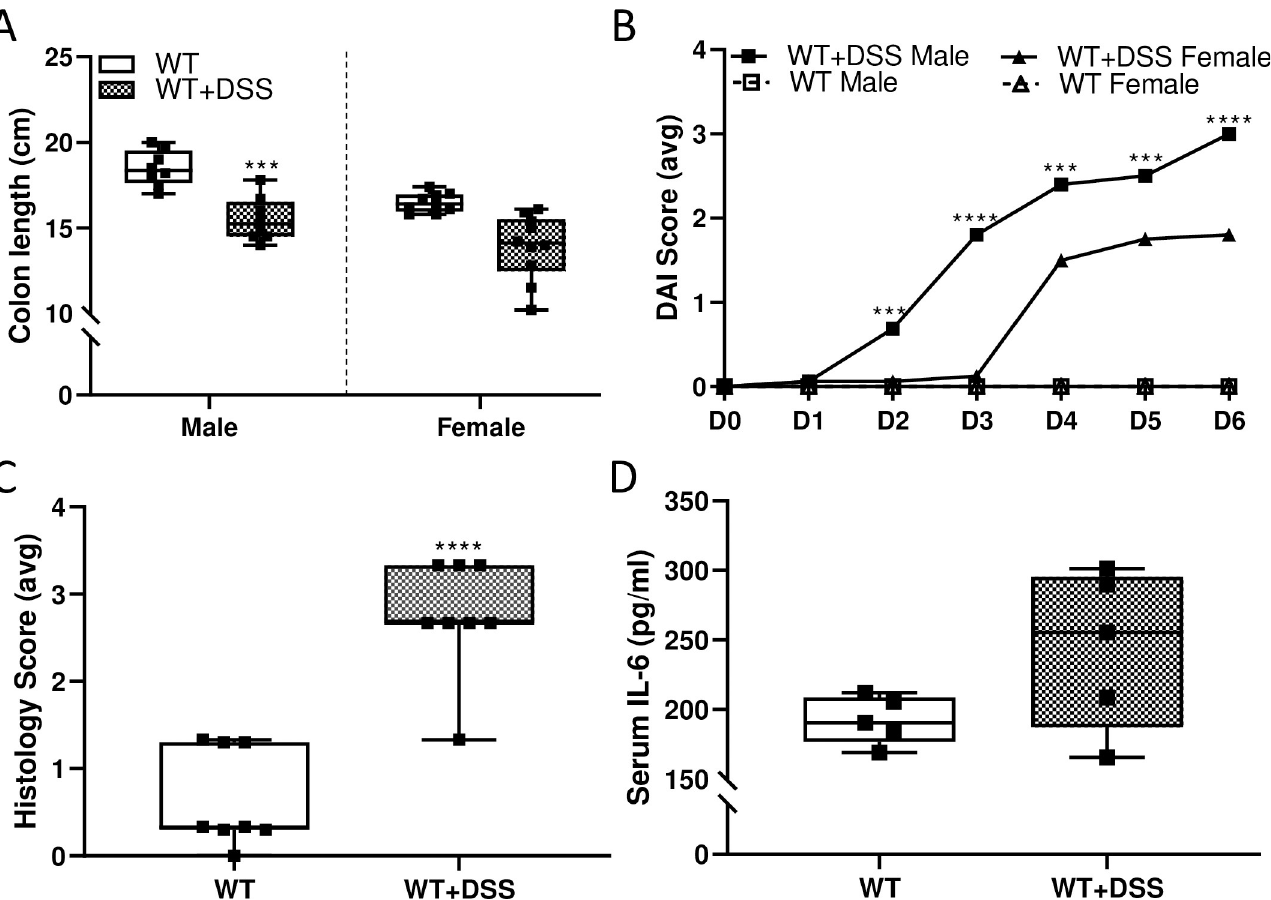
Fig 12. Oral DSS administration caused colitis with GI tract-restricted inflammation in 10-week-old rats of both sexes. Length of the colon, defined as the end of the cecum to the anus, was measured as a macroscopic indicator of DSS-related colonic damage ( A ). Data are presented as box plots for n = 7–11 rats/ group and were analyzed separately by sex using a two-sample t test ( ��� p < 0.001). Disease Activity Index (DAI) scores were also calculated daily ( B ). Average scores on each day for each sex and experimental group are depicted in the graph. Data for WT+DSS male and WT+DSS female were compared by two-way ANOVA with repeated measures (Day × Group, p < 0.001). Individual t-tests were then used to compare groups at each treatment day ( ��� p < 0.001; ���� p < 0.0001); n = 7–11 rats/group. Furthermore, H&E-stained tissue sections from the descending colon of male WT rats were blindly scored in 3 randomly selected areas, and histology scores were generated ( C ). Data are presented as box plots for n = 10 rats/group and were analyzed by a two-sample t